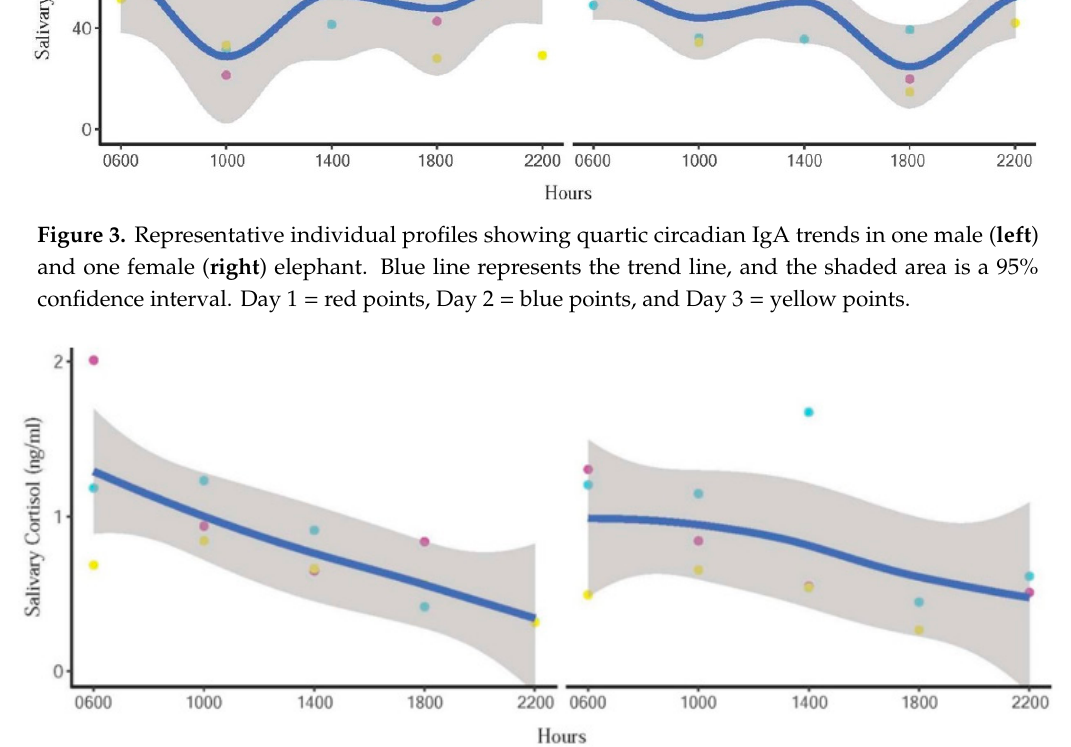
Figure 4. Representative individual profiles showing linear circadian cortisol trends in one male ( left ) and one female ( right ) elephant. Blue line represents the trend line, and the shaded area is a 95% confidence interval. Day 1 = red points, Day 2 = blue points, and Day 3 = yellow points.